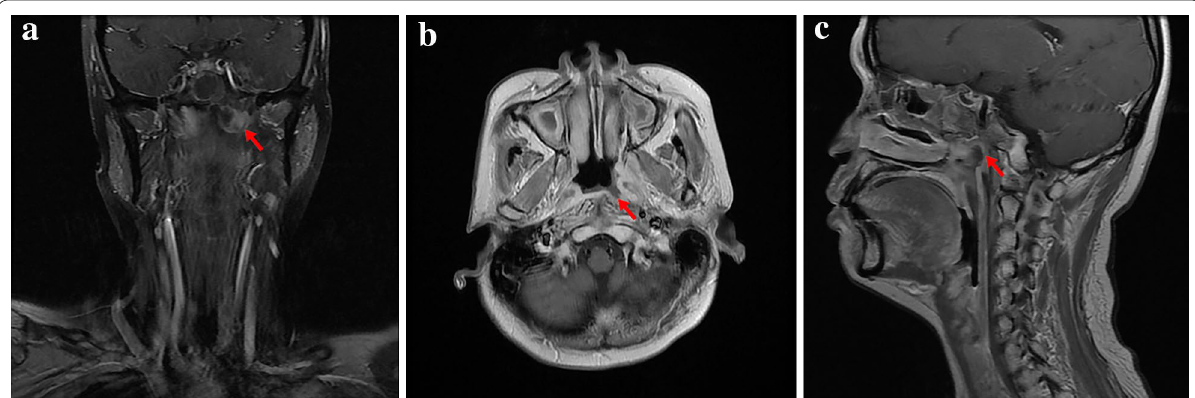
Fig. 1 Magnetic resonance imaging of nasopharyngeal necrosis. a Coronal, contrast‑enhanced, T1‑weighted image shows non‑enhanced soft tis‑ sues (like a hole) mixed with tiny air bubbles in the left nasopharyngeal lateral recess ( arrow ). b Transverse, contrast‑enhanced, T1‑weighted image shows the necrotic extent in the nasopharyngeal posterior wall ( arrow ). c Sagittal, contrast‑enhanced, T1‑weighted image shows an obvious defect in the left nasopharyngeal lateral recess ( arrow )